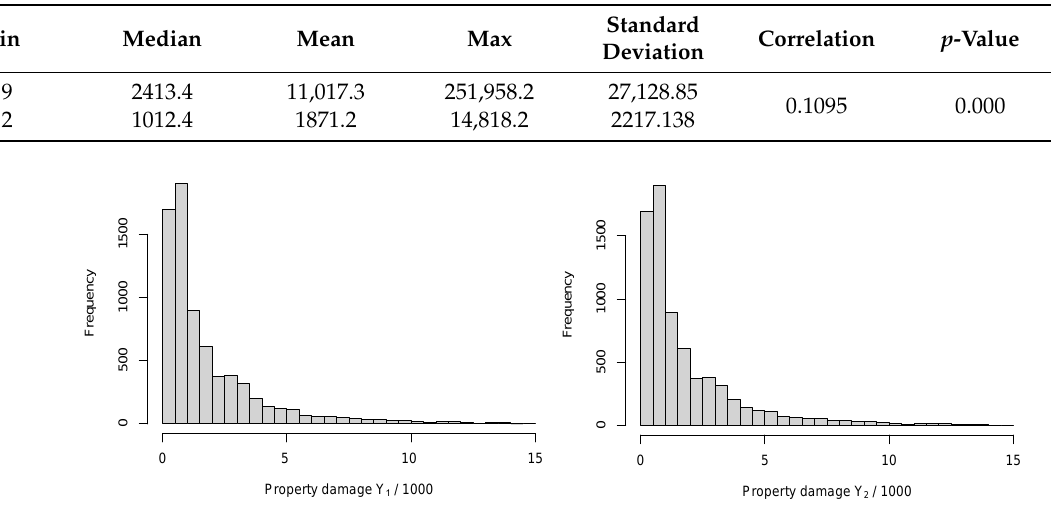
Figure 1. Empirical distribution of two types of d claim